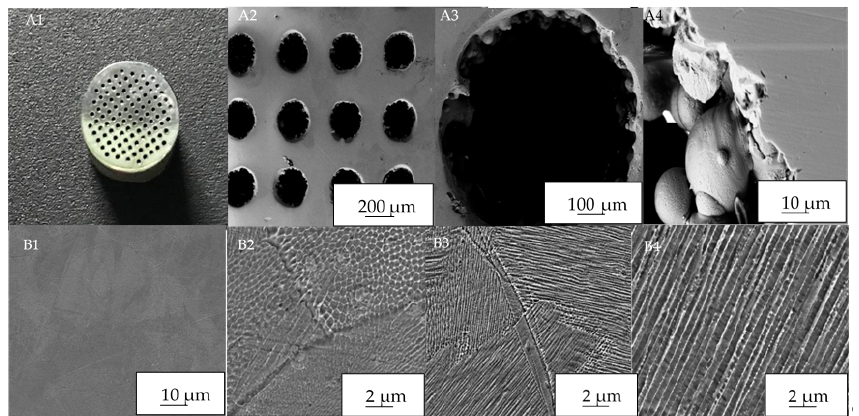
Figure 9. ( A1 ) Optical morphology and porous scaffolds: ( A2 – A4 ) Representational SEM images of porous scaffolds at different magnifications. Microstructure photographs of porous scaffolds under SEM: ( B1 – B4 ) Microstructure photographs at different magnifications.